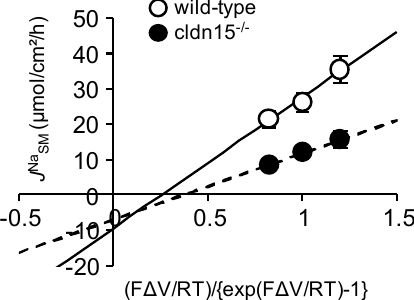
Figure 7. The effect of changing the transepithelial potential on J NaSM : J NaSM was measured at V te = 0 and ± 10 mV. J NaSM was plotted as a function of (FΔV te /RT)/{exp(FΔV te /RT)−1}, where F is the Faraday constant, R is the molar gas constant, and T is the temperature. Lines are fitted with least-squares method. Wild-type (open circles, n = 6) and cldn15 −/− mice (closed circles, n = 4).